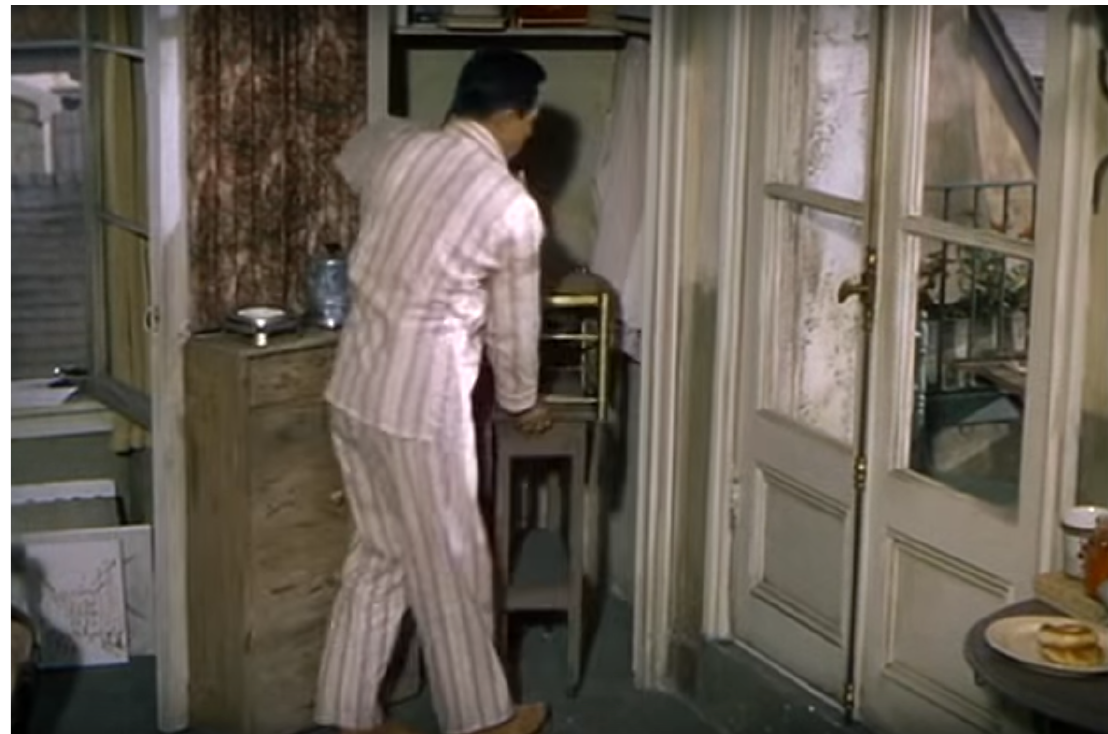
Figure 1. Gene Kelly, a scene from Vincente Minnelli’s movie An American in Paris (1951). Source: Freed and Minnelli (1951).